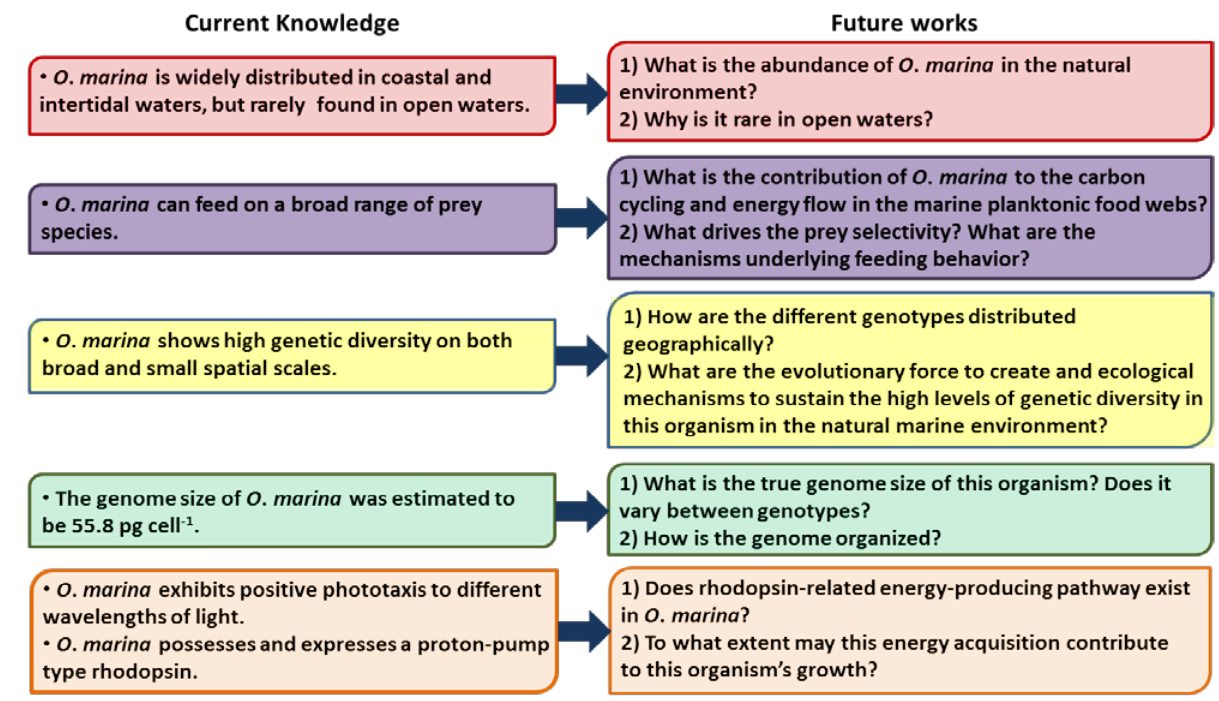
Figure 2. Diagram summarizing the current status of knowledge in key areas and showing proposed future research topics to address the inadequacy of those